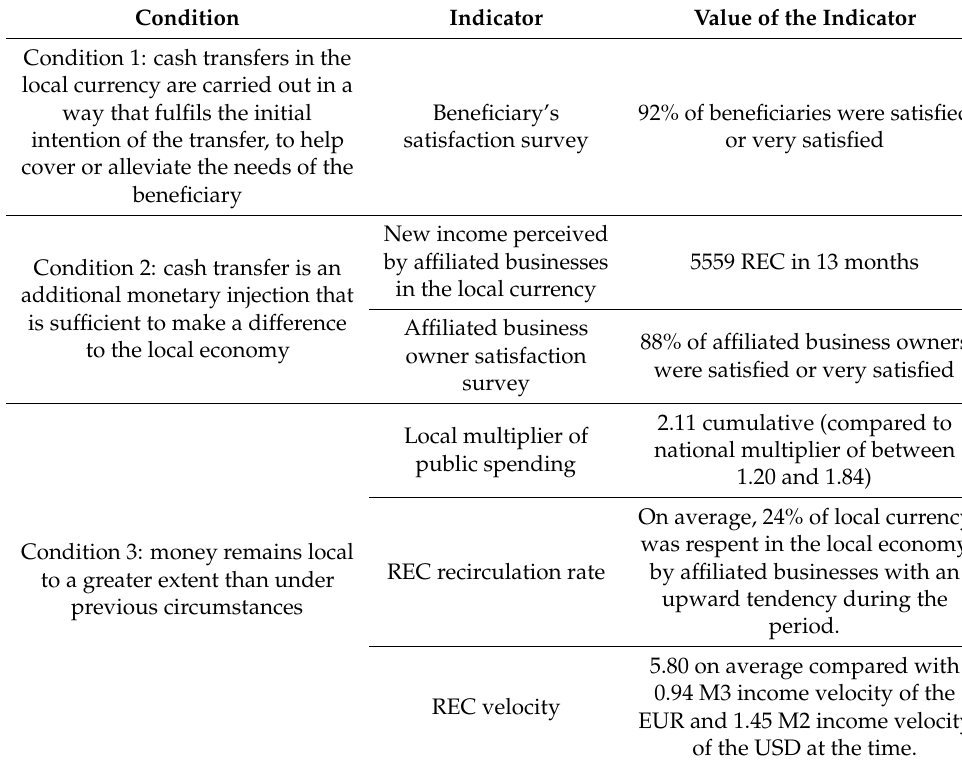
Table 3. Descriptive framework of REC Barcelona 13 month pilot